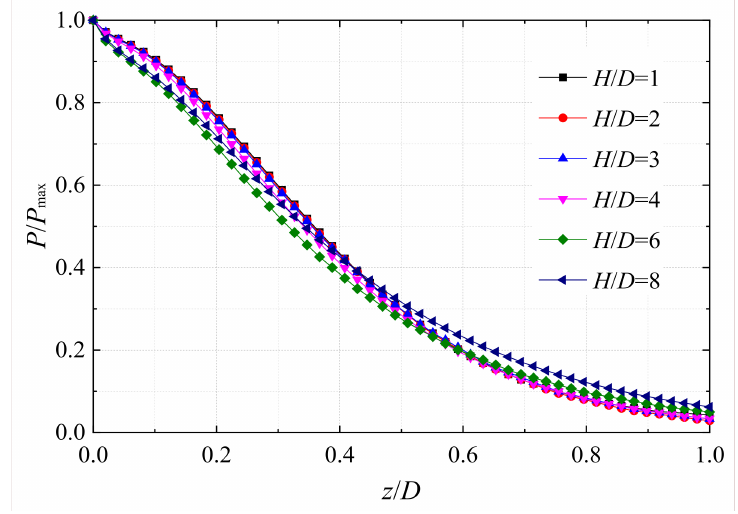
Figure 18. The axial distribution of dimensionless pressure P/P max on the axis of the jet in the impingement